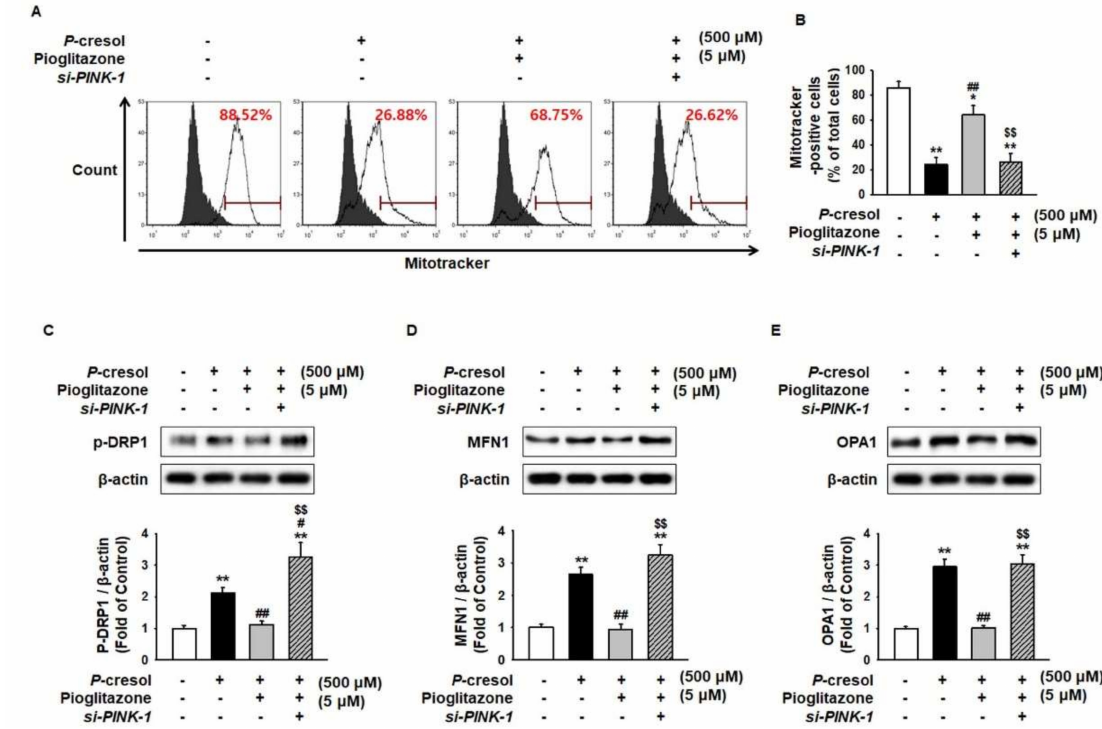
Figure 3. Pioglitazone-treated MSCs increased mitochondrial fission by increasing expression of PINK-1 on exposure to PC. ( A , B ) After PC (500 µ M) exposure for 72 h, mitochondria were measured using Mitotracker in si-PRNP -transfected MSCs after treatment with pioglitazone (5 µ M) for 24 h. Values represent the mean ± SEM. * p < 0.05 and ** p < 0.01 vs. untreated MSCs, ## p < 0.01 vs. MSCs exposed to PC, $$ p < 0.01 vs. MSCs treated with pioglitazone. ( C – E ) After the 72 h PC (500 µ M) exposure, Western blot was used to analyze the activation of phosphorylated dynamin-related protein 1 (p-DRP1) and the expression of mitofusin-1 (MFN1) and dynamin-like 120 kDa protein (OPA1) in MSCs after 24 h of treatment of small interfering-RNA PRioN Protein ( si-PRNP )-transfected MSCs with pioglitazone (5 µ M; 24 h). The expression levels were determined by densitometry relative to β -actin. Values represent the mean ± SEM. ** p < 0.01 vs. untreated MSCs, # p < 0.05 and ## p < 0.01 vs. MSCs exposed to PC, $$ p < 0.01 vs. MSCs treated with